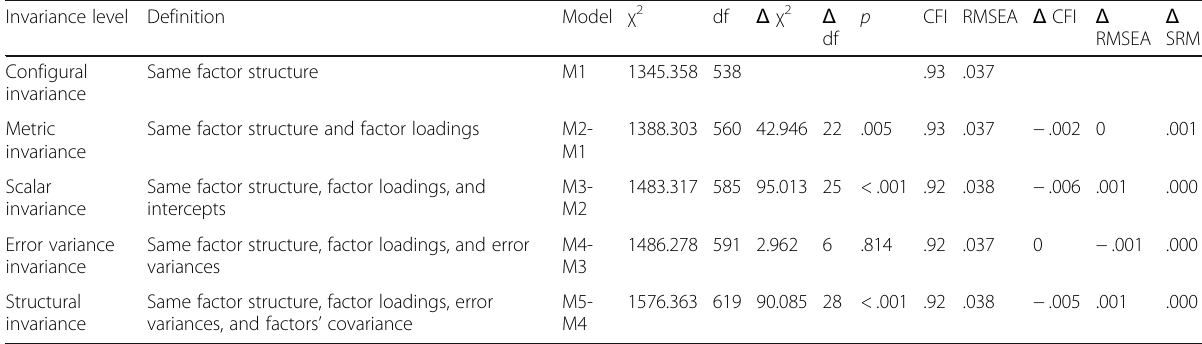
standardized root mean square residuals, M1 to M5 models